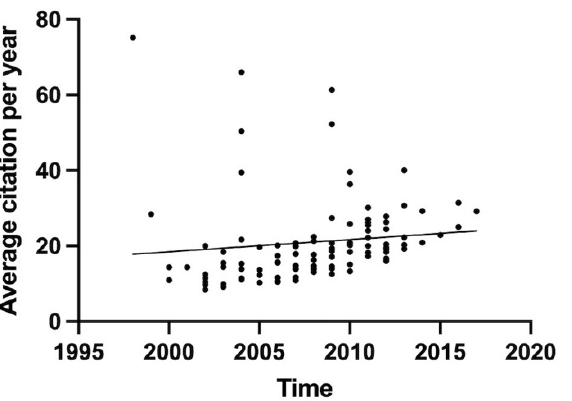
Figure 2. Time-dependent average citation per year trend from 1998 to 2017. The Mann–Kendall trend test showed an increasing trend between citation density and time ( p ≤ 0.0001).